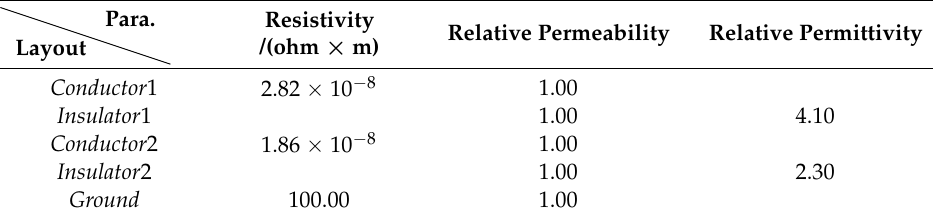
Figure A1. Geometric parameters of dc cable. Table A1. Electrical properties for cable.